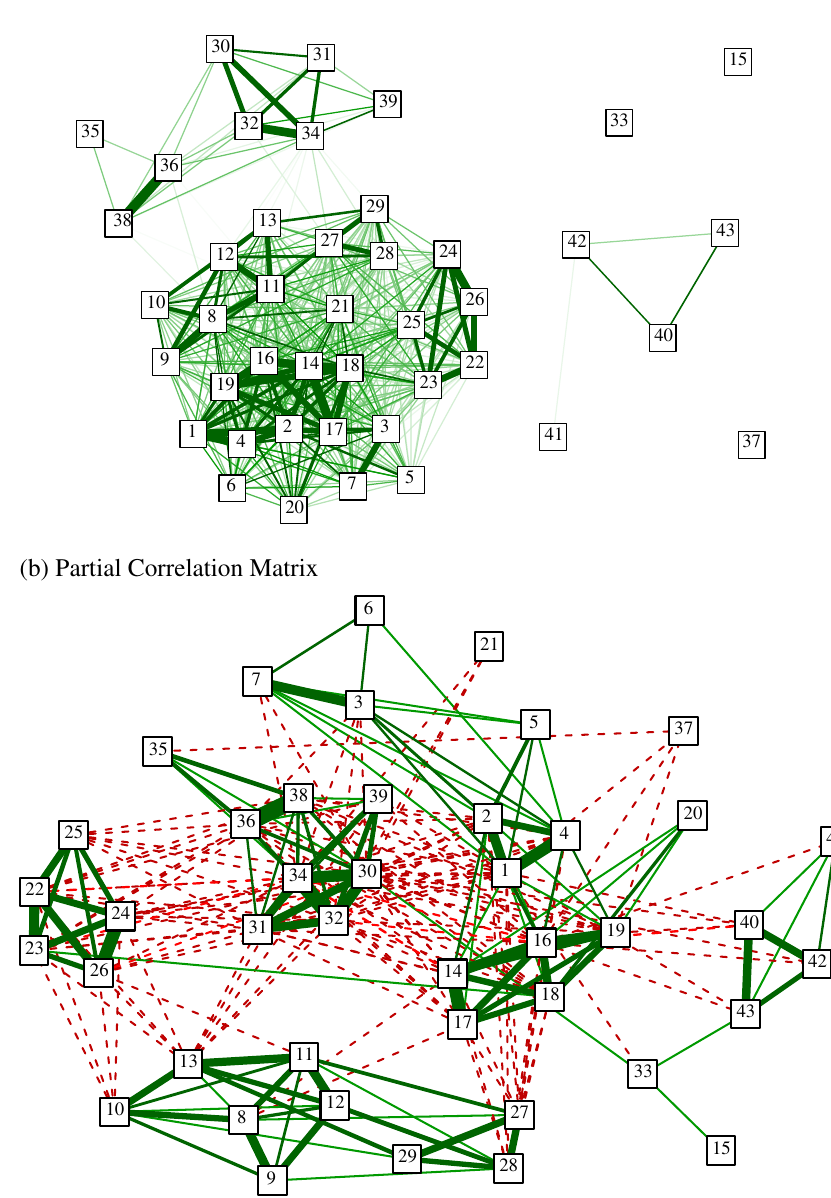
FIG. 1. (a) FMCE correlation matrix ( j r j > 0 . 3 ) and (b) FMCE partial correlation matrix ( j r j > 0 . 1 ). Line thickness represents the size of the correlation. Solid (green) lines represent positive correlations; dashed (red) lines negative